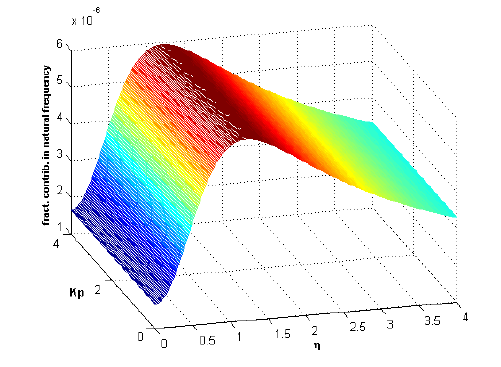
Figure 13. Fractional contribution frequency versus stiffness Kp and nonlocality η ( α = 0.2).